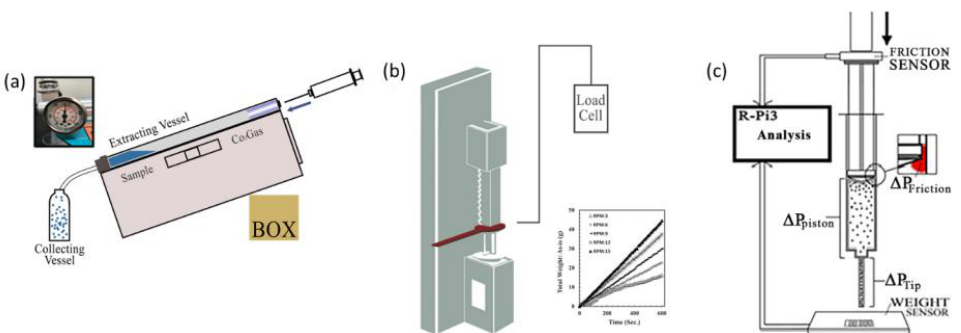
Figure 1. ( a ) A conceptual diagram of a supercritical extraction system, including a collection vessel, a sample extraction vessel, and a pressure monitor, and images of OCO-LABS parts. ( b ) IoT system